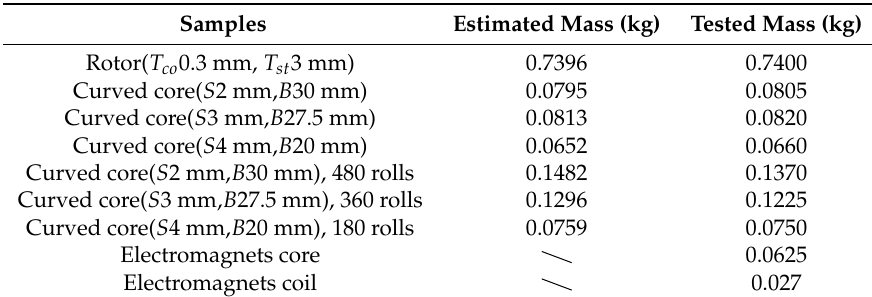
Table 3. Mass estimation and experimental